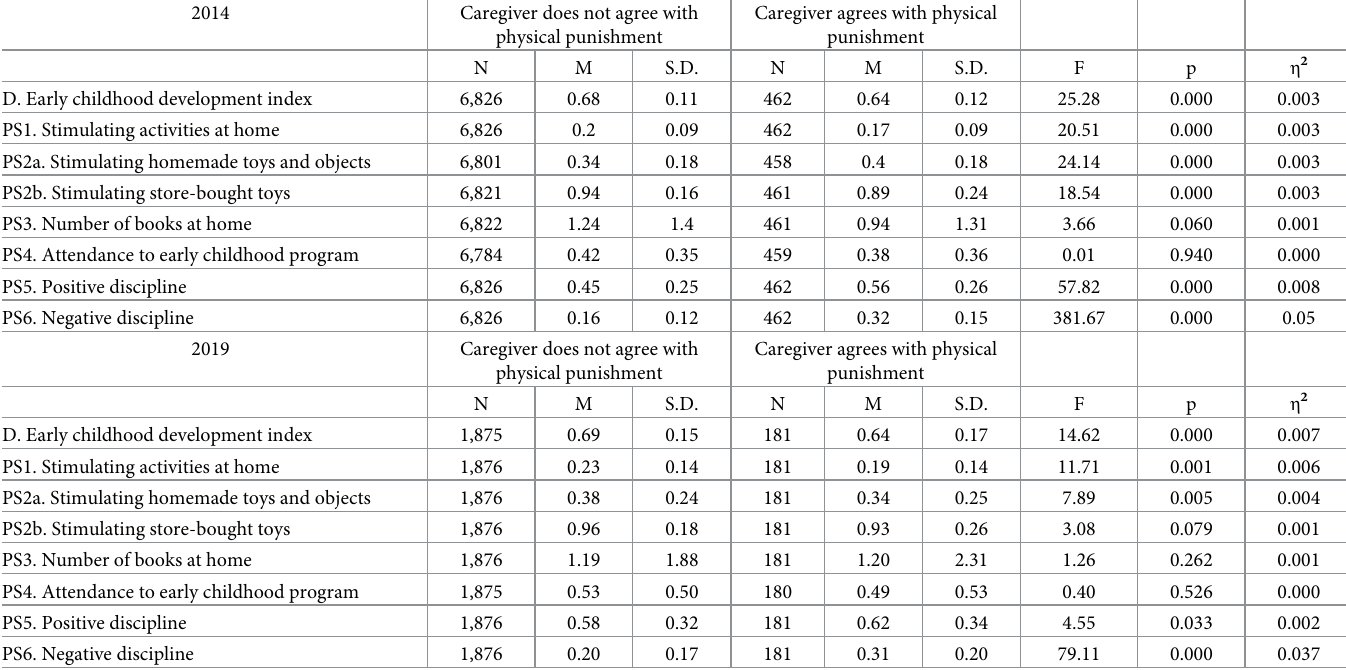
Table 5. Descriptive statistics by caregivers who agree and who do not agree that children must be physically punished. MICS Dominican Republic 2014 and